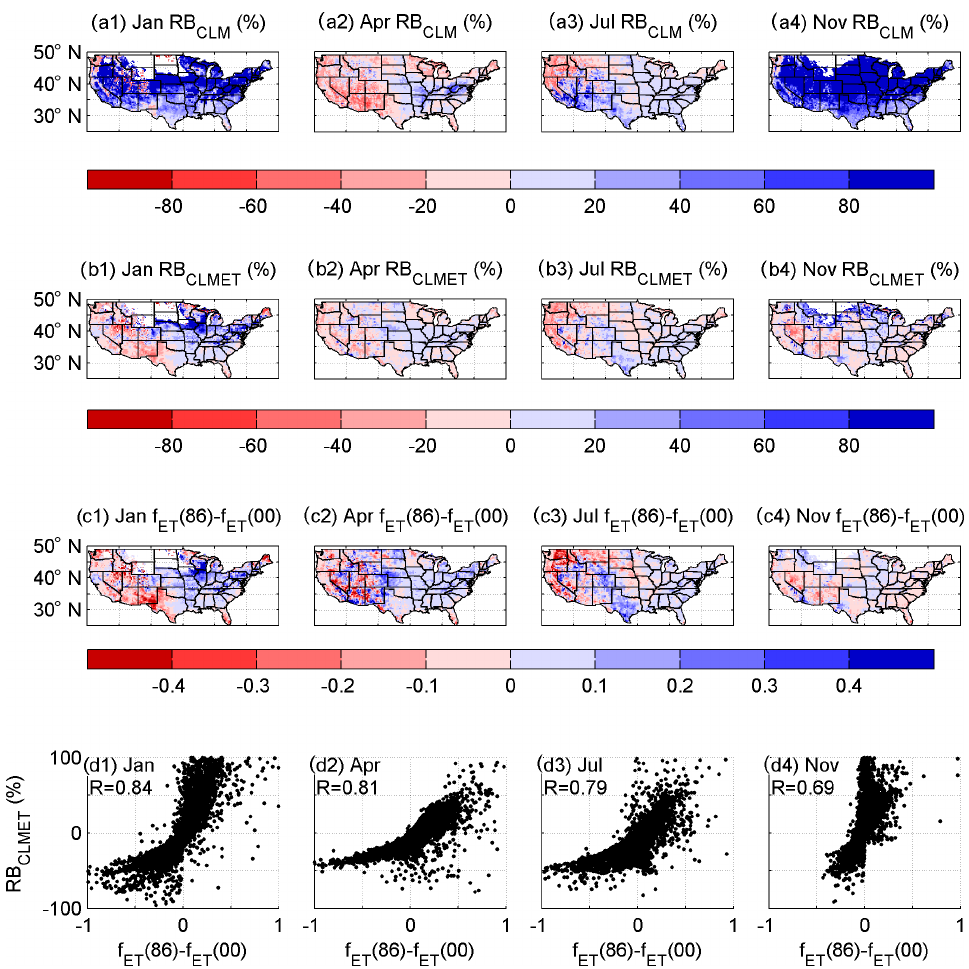
Figure 4. (a) Relative bias (RB) for the CLM (RB CLM ), (b) RB for CLMET (RB CLMET ) during the period 2000–2014, (c) difference in scaling factor f ET between the period 1986–1995 and the period 2000–2014 ( f ET ( 86 ) − f ET ( 00 ) ), and (d) scatter plots of f ET ( 86 ) − f ET ( 00 ) vs. RB CLMET in (1) January (Jan), (2) April (Apr), (3) July (Jul), and (4) November